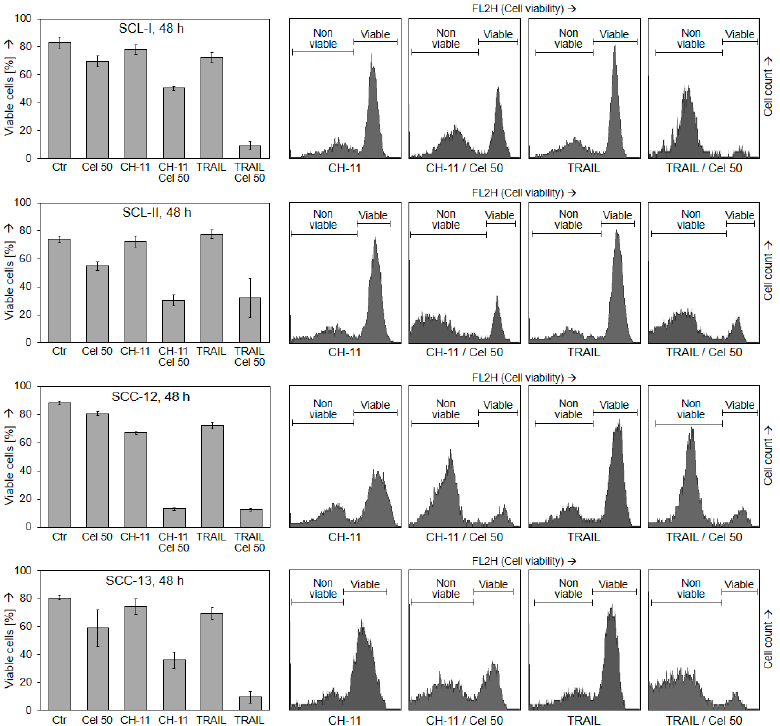
Figure 3. Loss of cell viability in combinations with death ligands. Cell lines SCL-I, SCL-II, SCC-12 and SCC-13 were treated with celecoxib (50 µM), CH-11 (100 ng/mL), TRAIL (50 ng/mL) or combinations. Cell viability was determined at 48 h by calcein staining and flow cytometry. Left, results of representative experiments are shown. At least two independent experiments, each one with triplicate values, revealed highly comparable results. Right side, examples of flow cytometry measurements (CH-11, TRAIL and combination treatments) are shown; viable and non-viable cell populations are indicated.